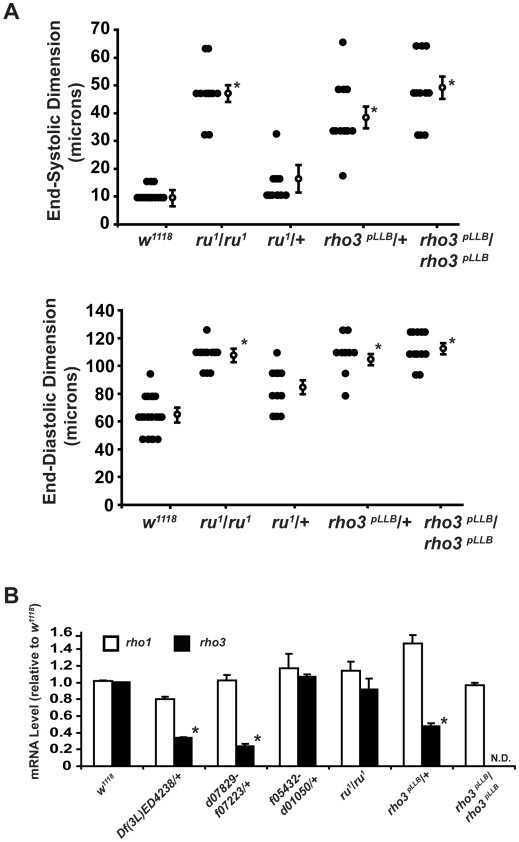
Flies with mutant alleles encoding ru1 or rho3pLLB have enlarged cardiac chambers.(A) Summary data of cardiac measurements for end-systolic dimension (ESD) (top) and end-diastolic dimension (EDD) (bottom) from w1118, ru1 homozygotes (designated ru1/ru1), ru1 heterozygotes (ru1/+), rho3pLLB heterozygotes (rho3pLLB/+), and rho3pLLB homozygotes (rho3pLLB/rho3pLLB). Closed circles represent individual measurements for each group, open circles represent the mean ± SEM for each group. n = 8−17 flies per group. *p<0.05 for the indicated measurements by ANOVA with Bonferroni correction for multiple comparisons for EDD or Kruskal-Wallis test with a Dunn's test for multiple comparisons for ESD. (B) Summary data for expression of mRNA for rho1 or rho3 in w1118, Df(3L)ED4238/+, heterozygous genomic deficiencies d07829-f07223/+ or f05432-d01050/+, ru1 homozygous mutants (ru1/ru1), rho3pLLB heterozygotes (rho3pLLB/+), or rho3pLLB homozygotes (rho3pLLB/rho3pLLB). Values are expressed as the mean mRNA expression +/- SEM relative to w1118 and represent three independent experiments using 10 flies per group per experiment. Rho3 mRNA was not detected (N.D.) in rho3pLLB homozygotes. *p<0.05 for rho3 in Df(3L)ED4328/+, d07829-f07223/+, or rho3pLLB/+ versus w1118 by t-test.